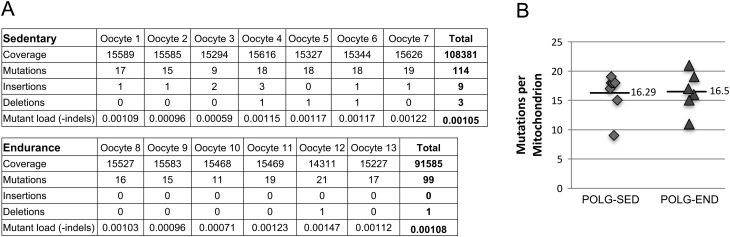
Exercise does not impact mitochondrial mutations in oocytes from POLG mice. (A) mtDNA sequencing coverage, numbers of mutations, insertions and deletions, and total mutational load in single oocytes from individual sedentary (n = 7 oocytes) and endurance-exercised (n = 6 oocytes) 7-month-old POLG mice. (B) Average mutational number in POLG-sedentary (POLG-SED) and POLG endurance-exercised (POLG-END) mice. Mean ± s.e.m.; no significant change in mutational number (P = 0.91) or mutational load (P = 0.80).